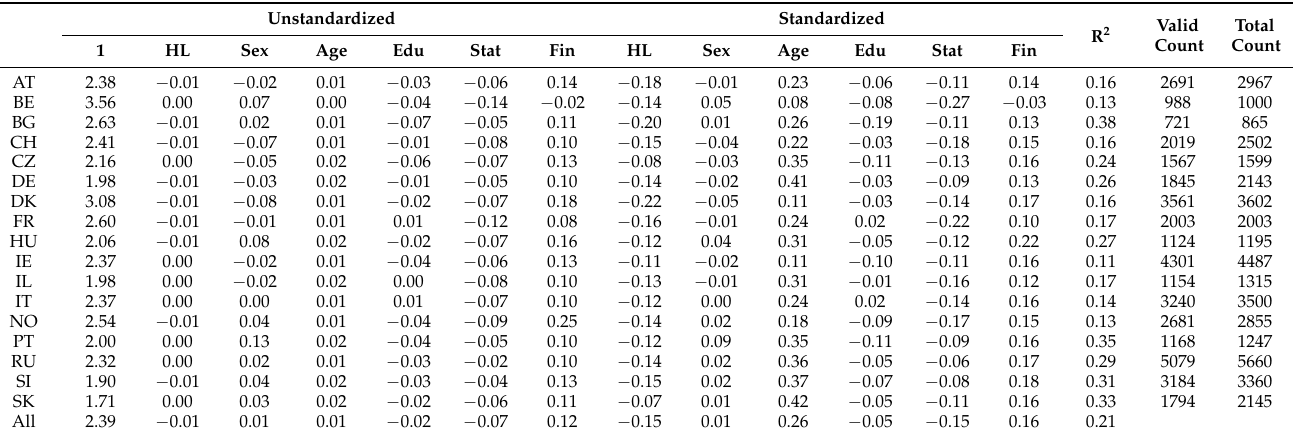
Table 15. Multivariable linear regression models of self-perceived health by general HL (D type) and five core social determinants (standardized coefficients ( β ) and R 2 ), for each country and for all countries (equally